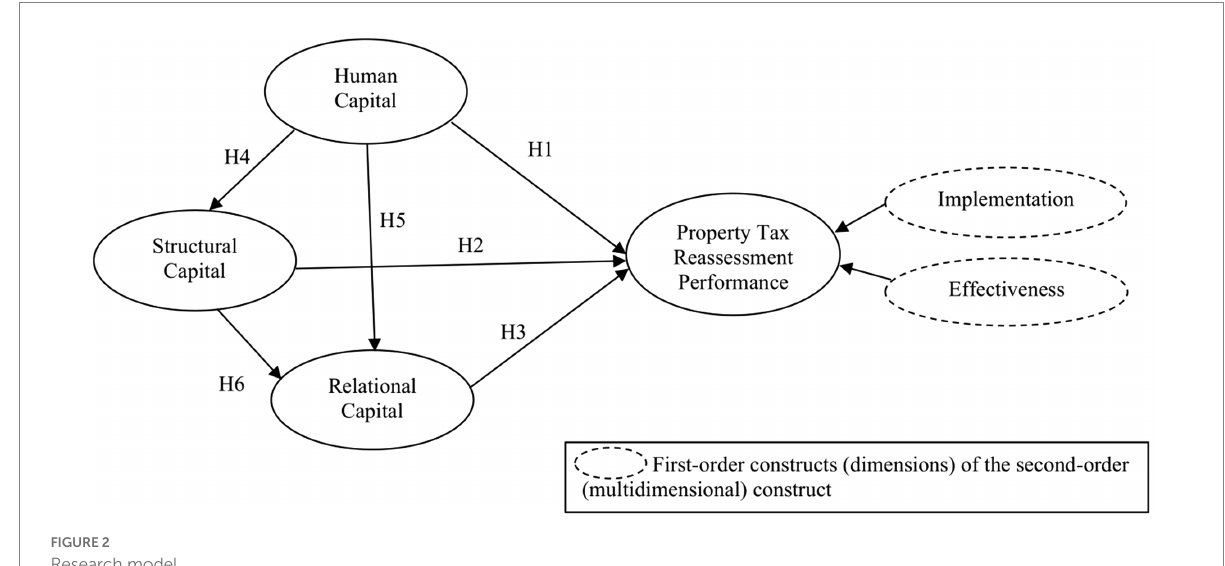
FIGURE 2 Research